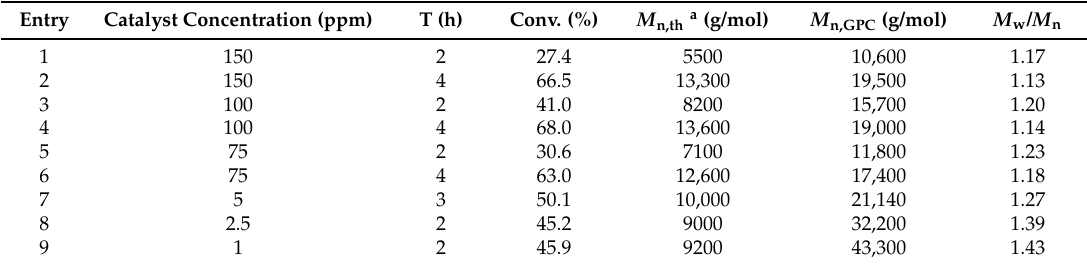
Table 3. Effect of the concentration of the catalyst on ICAR ATRP of MMA